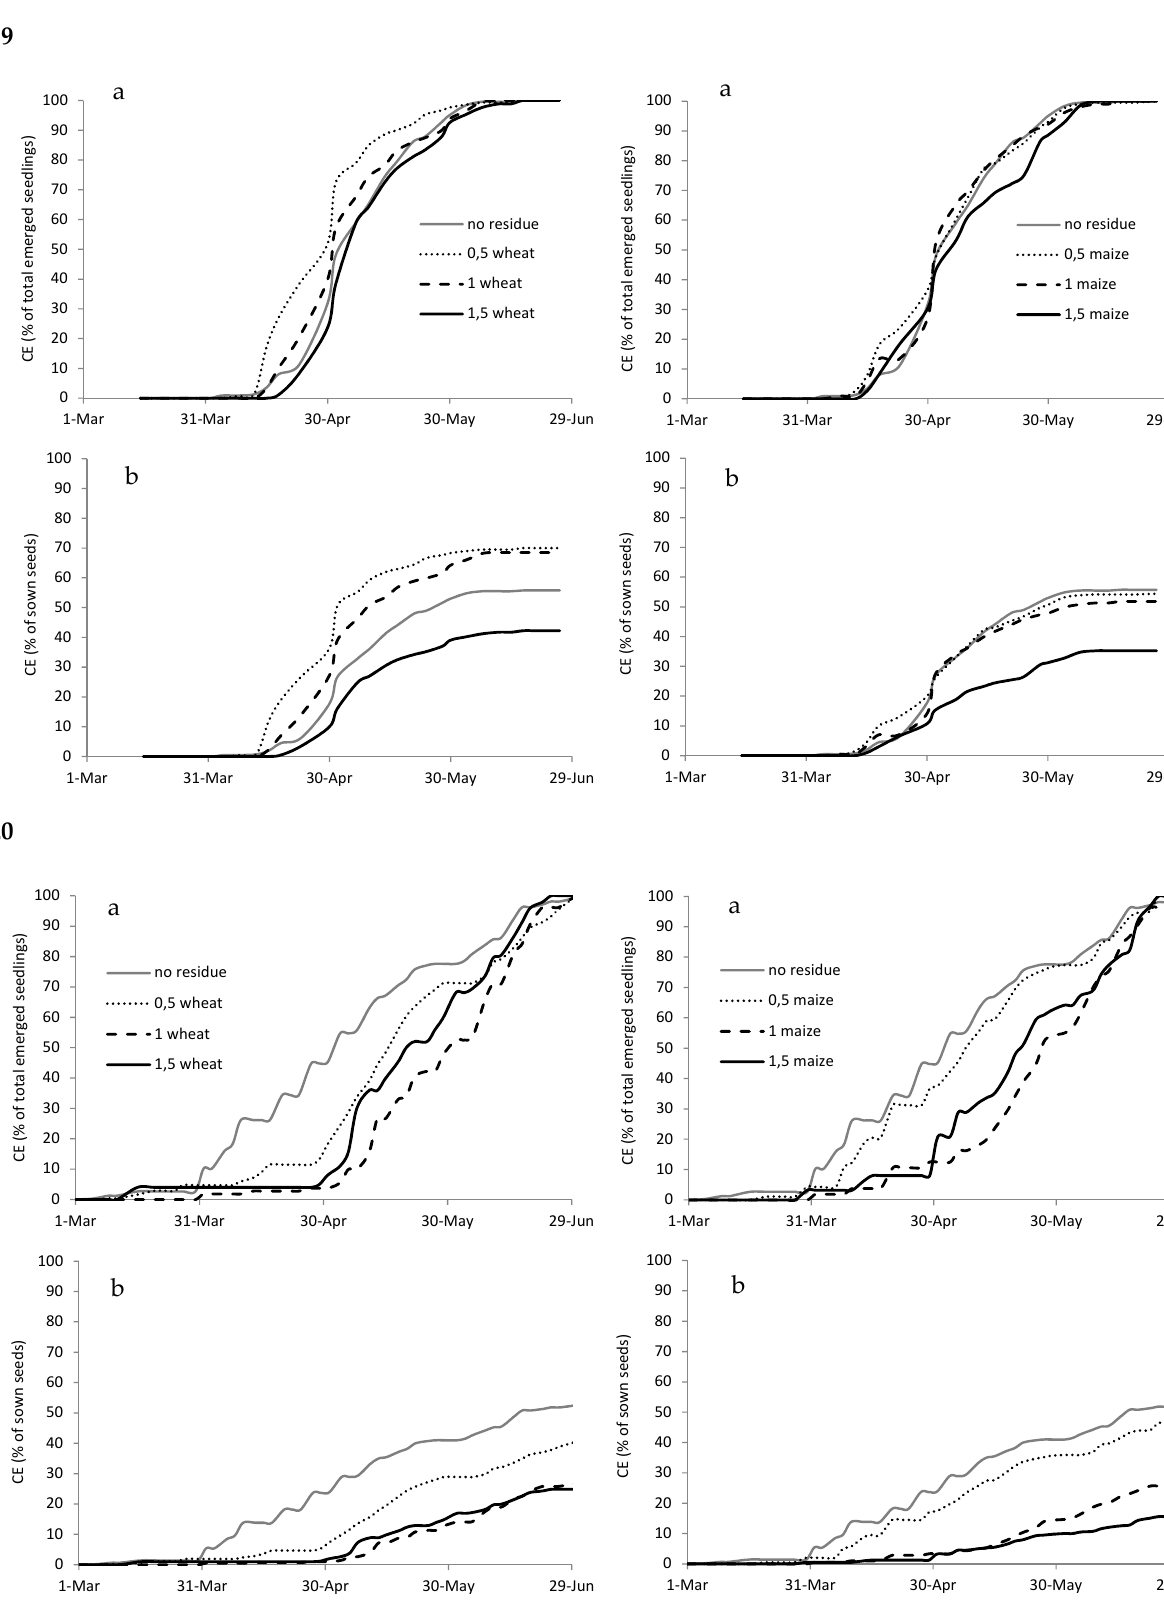
Figure A4. Cumulated emergence (CE) expressed as percentage of total emerged seedlings ( a ) and as percentage of sown seeds ( b ) of Digitaria sanguinalis in 2019 and 2020 with different types (wheat on the left and maize on the right) and amounts of crop residues.